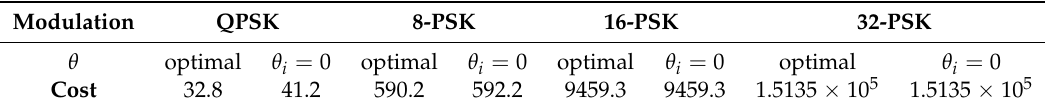
Figure 1. Three-dimensional graphs of the cost function in (21) as a function of θ 1 and θ 3 for BPSK, QPSK, 8-PSK, and 16-PSK modulation schemes and n R = 3. Table 2. The value of the cost function in (21) for optimal angles and θ i = 0 for several PSK modulation schemes and n R =